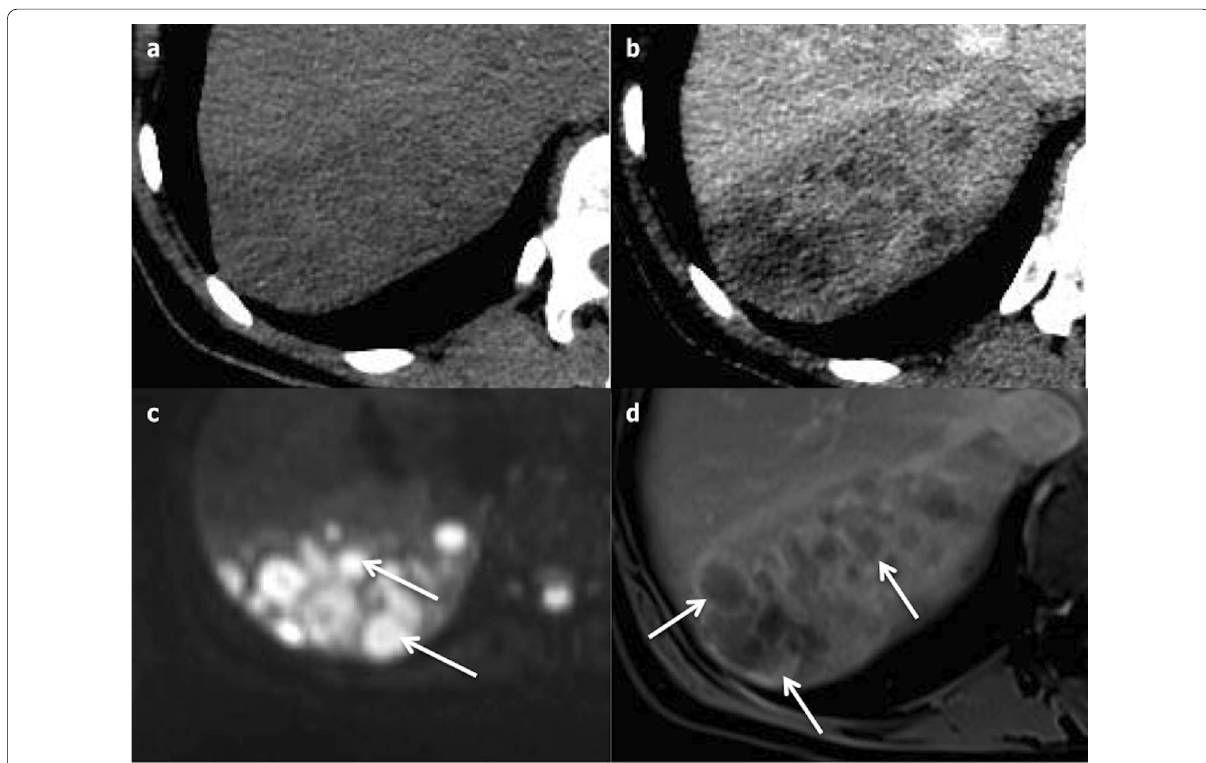
Fig. 20 Invasive mucinous cystic neoplasm of the liver in a 50-year-old female. a Axial non-enhanced computed tomography shows a hypoattenuating lesion with a thick heterogeneous enhancing wall on portal venous phase ( b ), better seen on T1-weighted magnetic resonance imaging on portal venous phase ( d ) (arrows). Note the presence of cystic portions on axial T2-weighted sequence ( c ), in very intense hypersignal T2